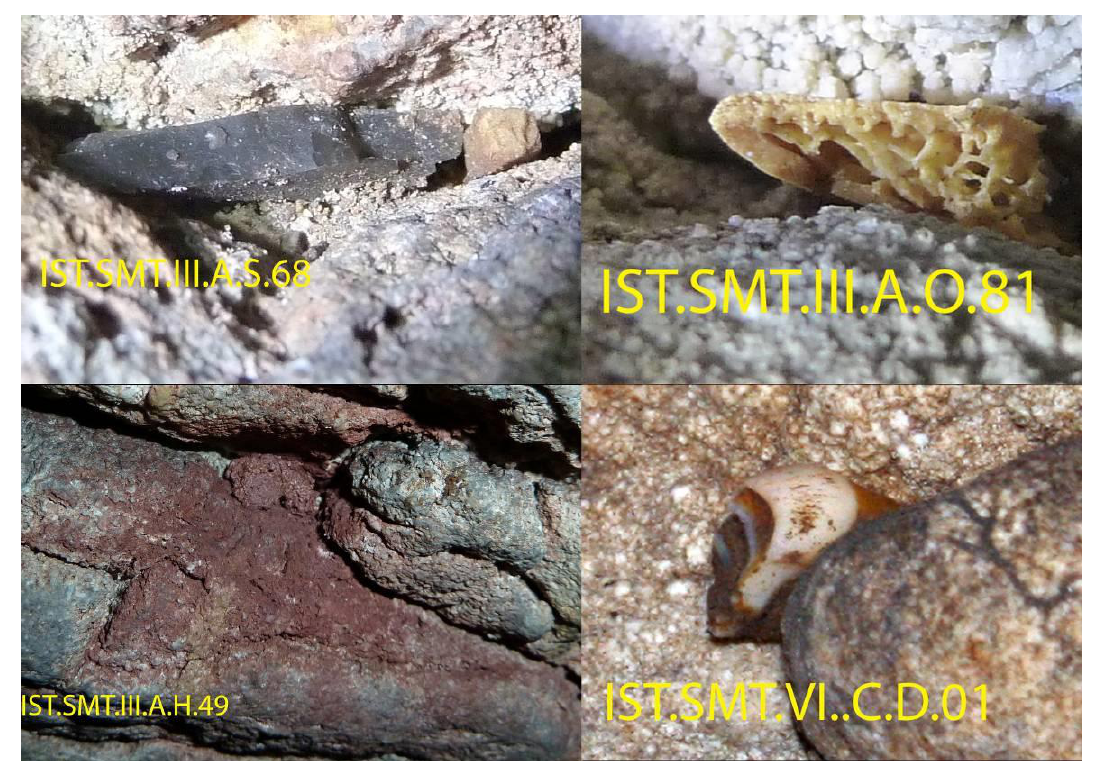
Figure 13. Various types of inserted objects in the Isturitz cave: flint, bone, ochre and